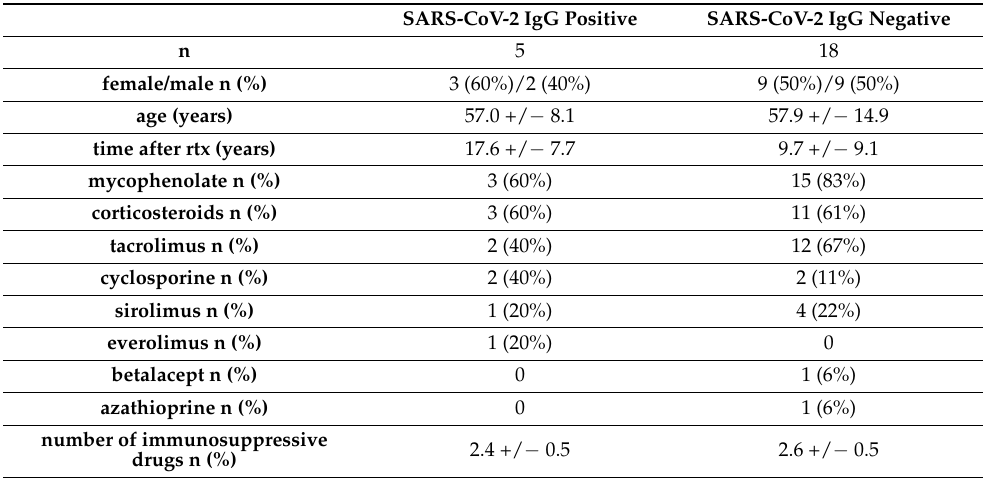
Table 2. Characteristics of renal transplant recipients who tested positive and negative for SARS.CoV- 2 IgG after two doses of the mRNA-based SARS-CoV-2 vaccine